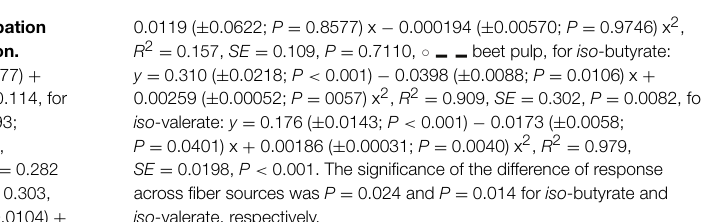
0.0119 ( ± 0.0622; P = 0 .8577) x − 0.000194 ( ± 0.00570; P = 0 .9746) x 2 , R 2 = 0 . 157 , SE = 0 . 109 , P = 0 .7110,